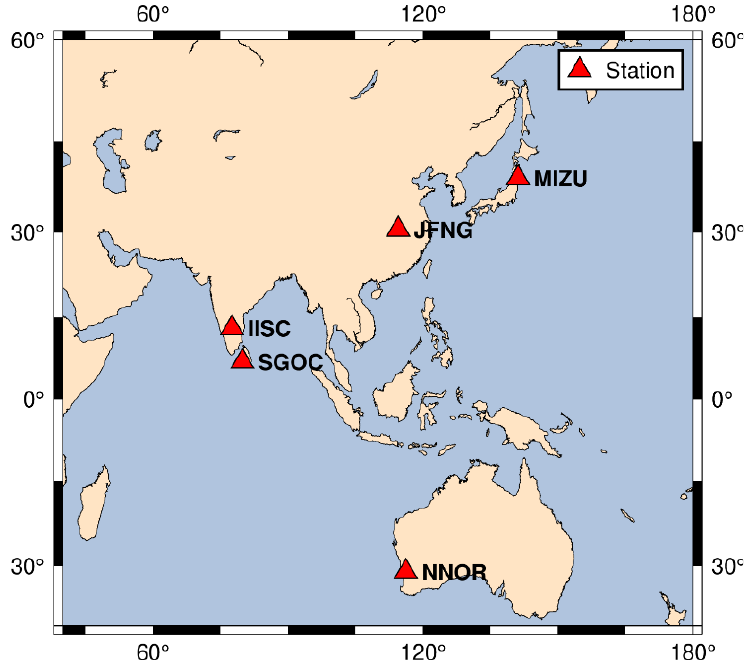
Figure 2. The location of selected stations for static experiments.